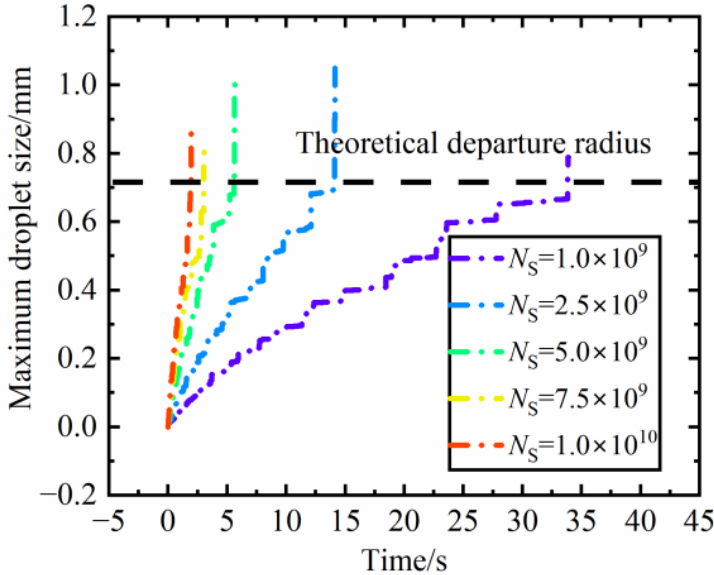
Figure 12. Variation of maximum droplet size under different nucleus densities.